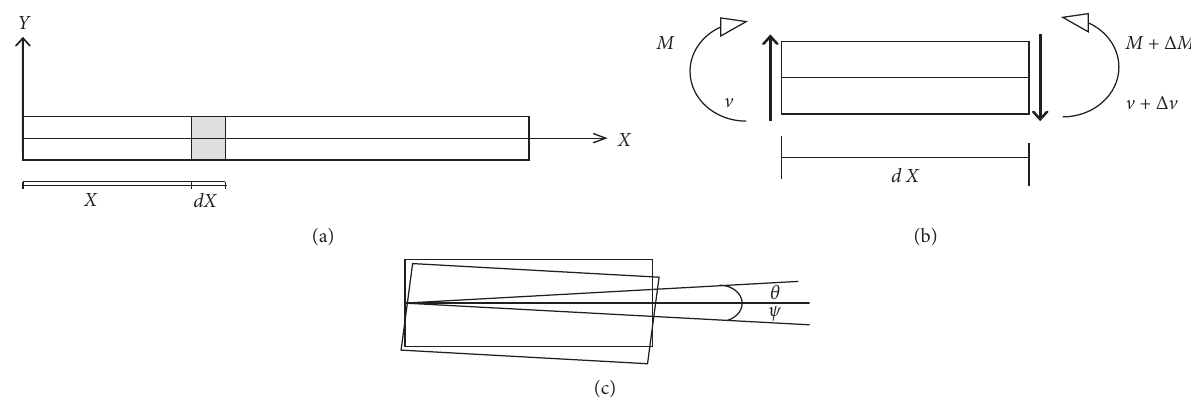
Figure 2: Section of a beam representing shear forces ( V ) and moments ( M ) at